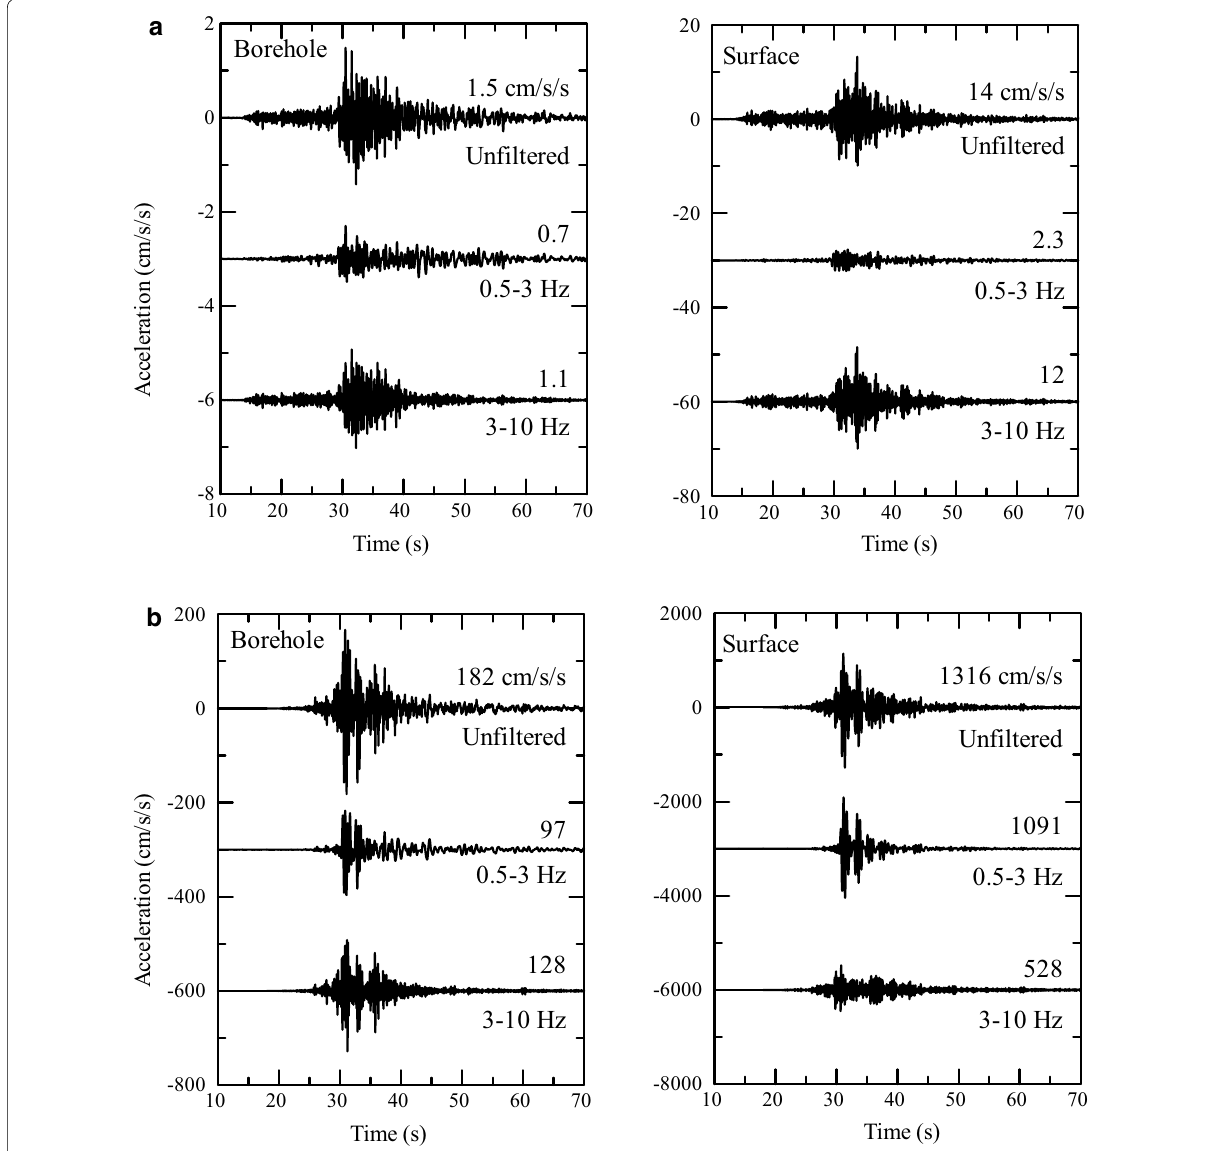
Fig. 6 Comparison of the borehole (left panel) and surface (right panel) NS component acceleration recordings for weak-motions ( a ) and mainshock ( b ) at site IBUH01 at different passband frequencies. The weak-motion recordings are from an event that occurred on November 1, 2006, at 23:21 JST (Mj 4.8, focal depth 49 km, epicentral distance 123 km, back azimuth 120°). In each panel, the uppermost recordings are = = = = unfiltered ones; the middle and lowermost recordings were bandpass filtered at 0.5–3 Hz and 3–10 Hz, respectively, as indicated in each plot. The maximum acceleration in the unit of cm/s 2 is indicated above each trace. Note that the scale of the vertical axis in the right panels is larger by a factor of 10 with respect to that in left